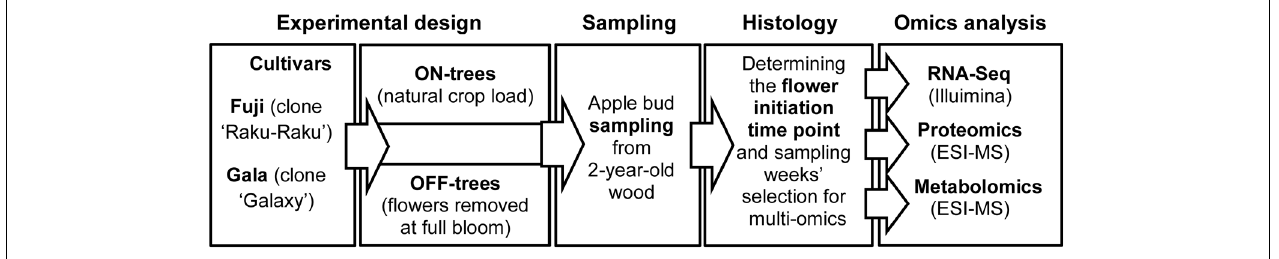
FIGURE 1 | Schematic diagram of the plant material, treatments, sampling scheme, and analytical procedures used in this study.